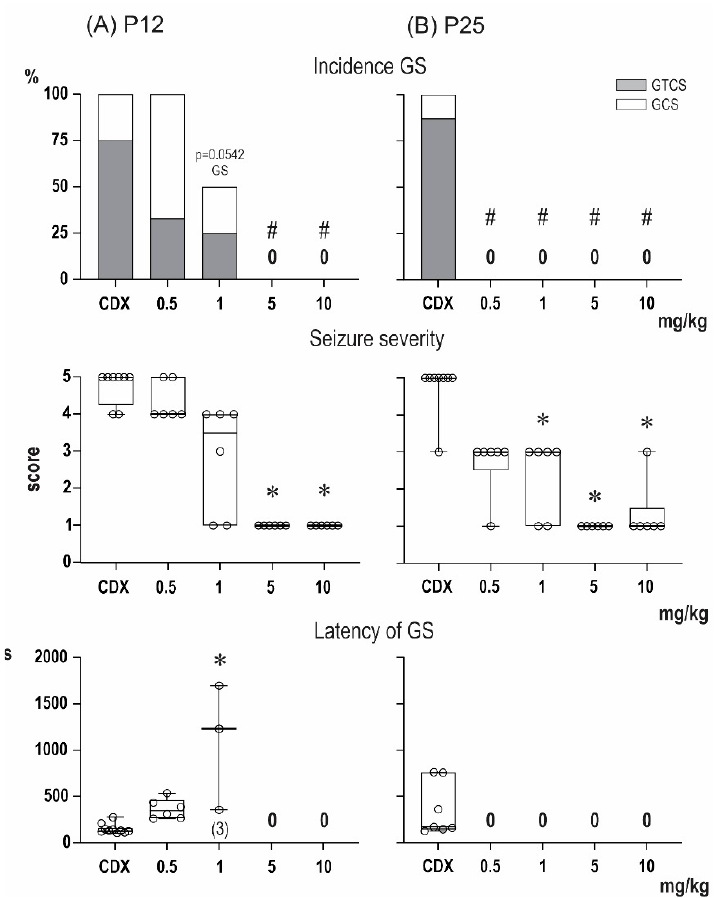
Figure 4. Effect of zuranolone on seizures induced by pentylenetetrazol in 12- ( A ) and 25-day-old rats ( B ). From top to bottom: the incidence of generalized seizures (GS) is shown in columns (the black parts indicate complete generalized tonic-clonic seizures; the white parts show generalized clonic seizures without the tonic phase). The severity of seizures is expressed as a score [20], and the latencies of generalized seizures are shown as box plots (min to max) with individual values (circles). # denotes a significant difference in the incidence of GS compared with the controls, * denotes a significant difference in the incidence of TF in seizure severity and GS latency compared with the controls, and 0 means that none of the rats in the group exhibited